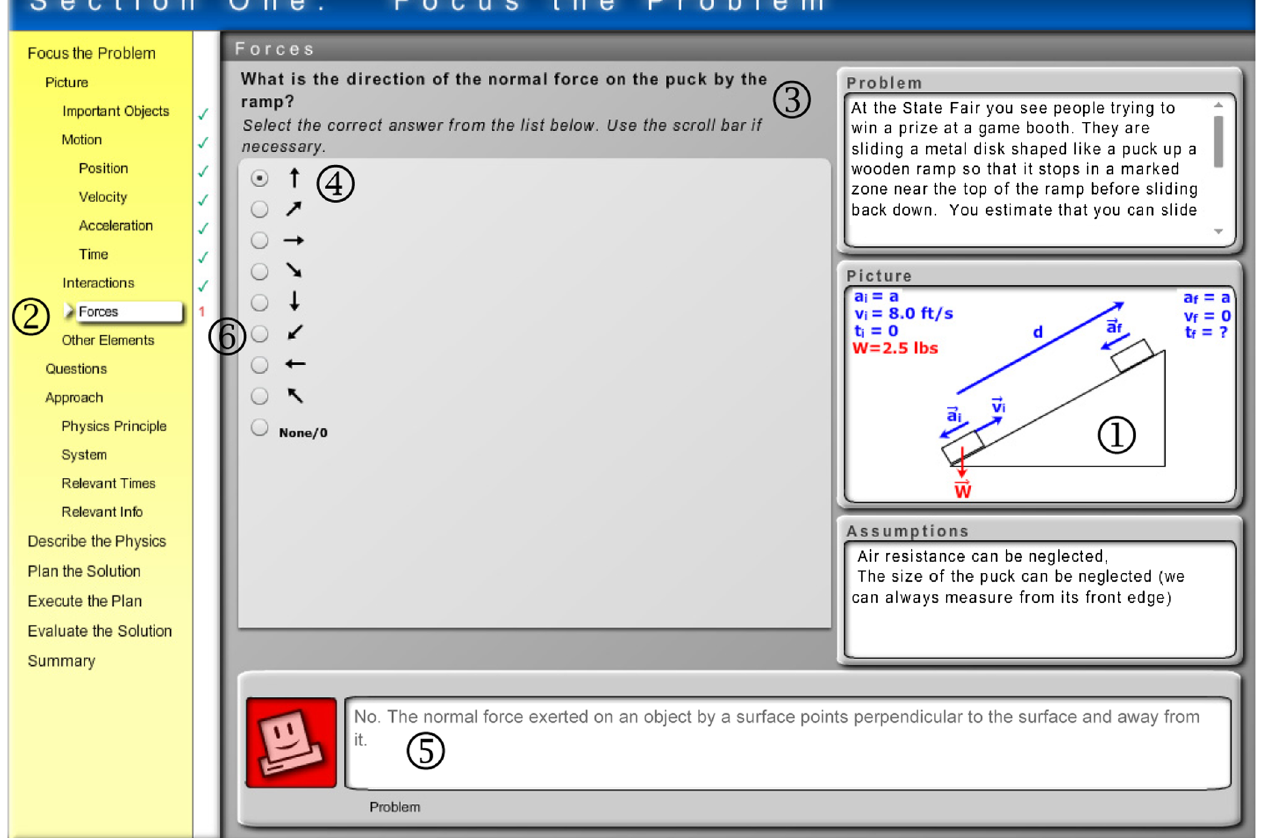
FIG. 1. Screenshot from a type 1 coach (computer coaches student). The display shows a partially completed picture ① . The computer specifies a step in the framework ② and asks the student to decide on the direction of a force ③ . The student ’ s decision ④ is incorrect, and the computer provides feedback ⑤ . A red number to the right of each step ⑥ indicates the number of incorrect responses the student made for that decision, while a checkmark indicates that the step was performed correctly the first